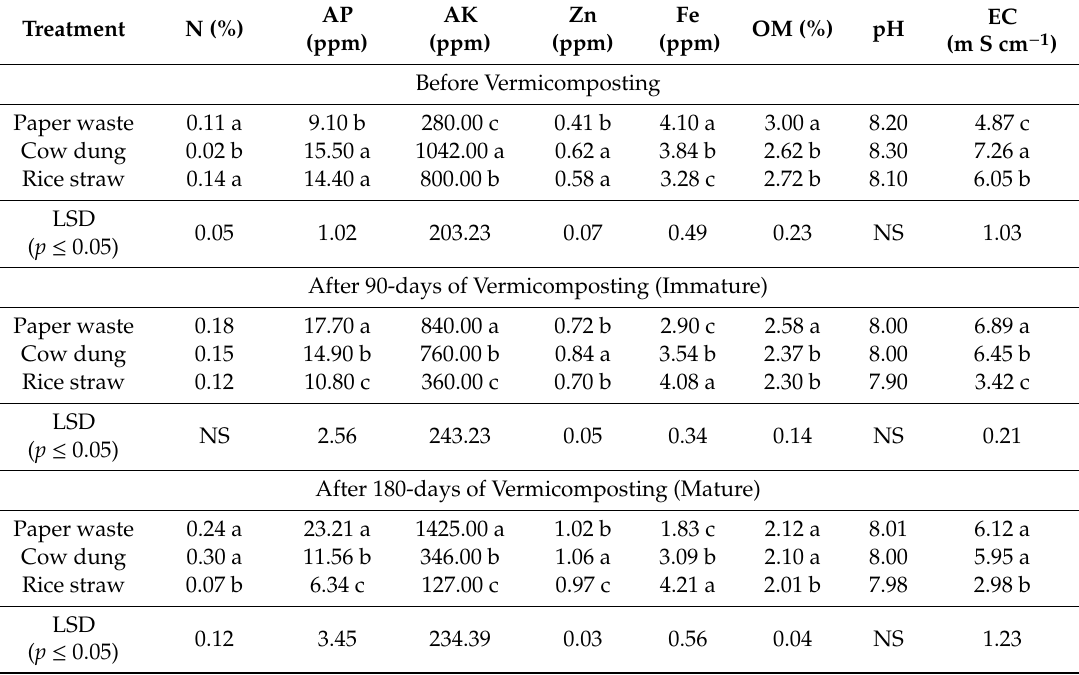
Table 3. Physio-chemical parameters of di ff erent organic wastes at di ff erent stages of vermicomposting.